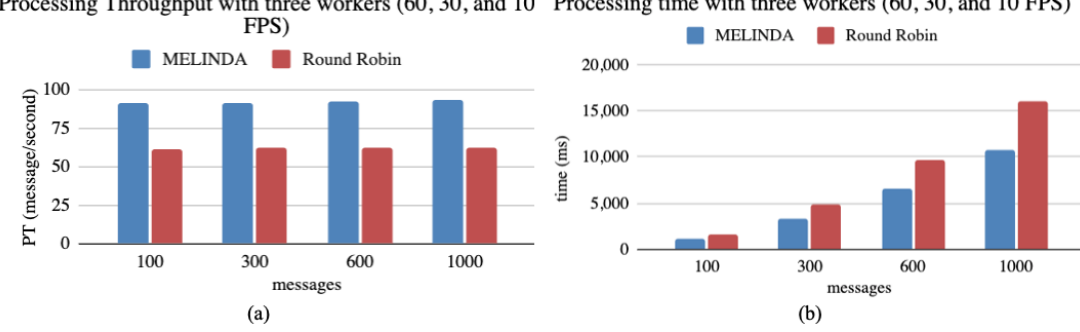
Figure 10. ( a ) Processing throughput; and ( b ) processing time with heterogeneous edge